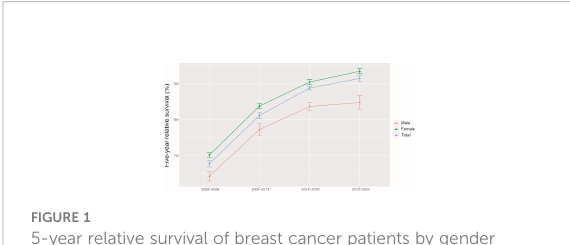
FIGURE 1 5-year relative survival of breast cancer patients by gender during 2004-2008, 2009-2013, 2014-2018 and 2019-2023.